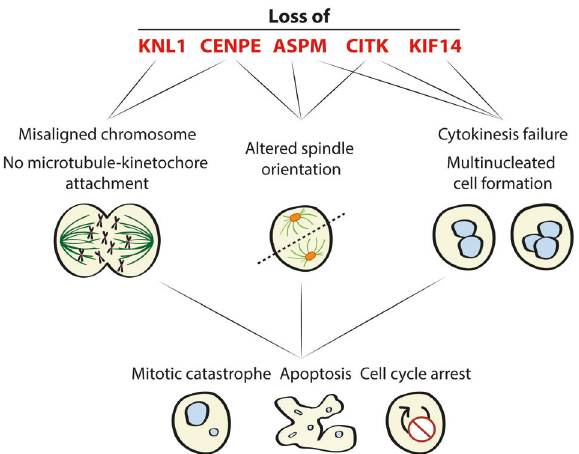
Fig. 2 Scheme of the effects observed after KNL1, ASPM, CENPE, CITK, and KIF14 loss. The loss of KNL1 and CENPE expression in proliferating cells leads to misaligned chromosomes and altered microtubule-kinetochore attachment. CENPE, ASPM, and CITK loss determines altered spindle poles orientation and oblique divisions. ASPM, CITK, and KIF14 loss leads to cytokinesis failure with the formation of multinucleated cells. These alterations can result in mitotic catastrophe or apoptosis or cell cycle